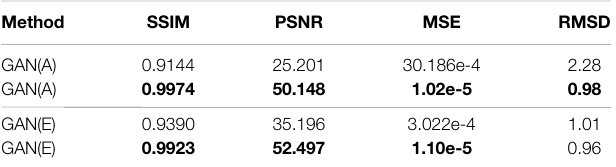
TABLE 5 | Quantitative results of comparison with GAN (Briñez de León et al., 2020c). (a) and (e) represent the results of processing the photoelastic fringes in Figure 6 . MSE is calculated after image normalization.